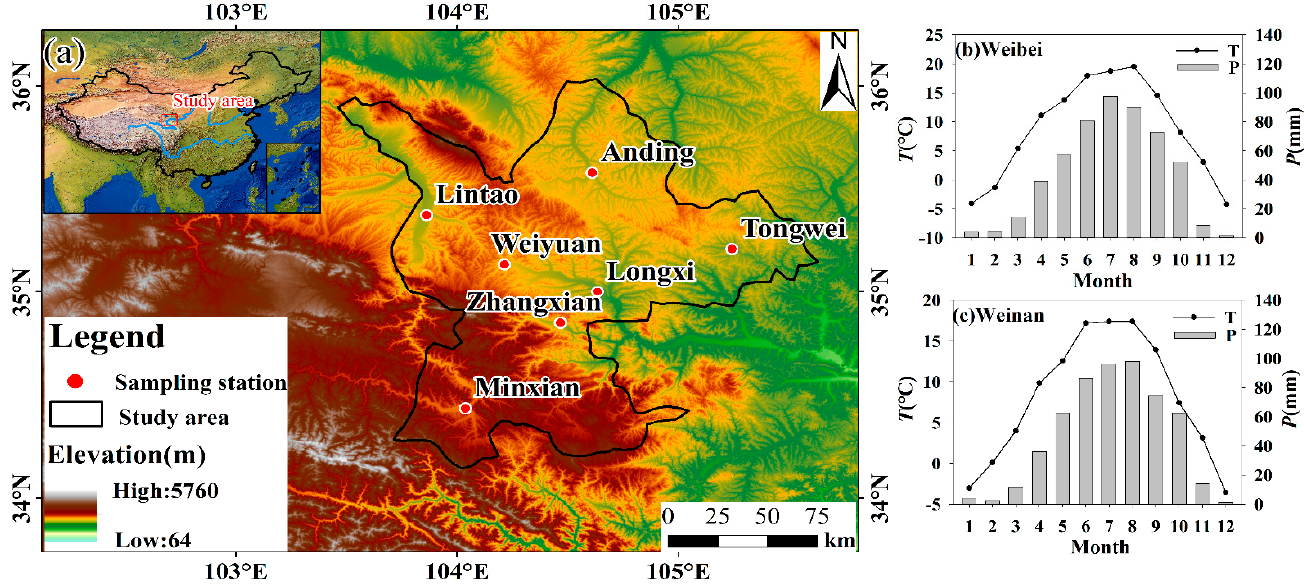
Figure 1. ( a ) Map showing the distribution of sampling stations. Spatial distribution of altitude in Dingxi, derived from China 30 Arc-Second Elevation (GDEMV2; http://www.gscloud.cn/ (accessed on 18 June 2021)). The satellite-derived land cover base map is from Natural Earth (http://www.naturalearthdata.com (accessed on 13 June 2021)). ( b , c ) Monthly mean air temperatures ( T ) and total precipitation ( P ) at Weibei and Weinan from April 2019 to April 2020. The line represents air temperature ( T ) and histogram represents precipitation ( P ).